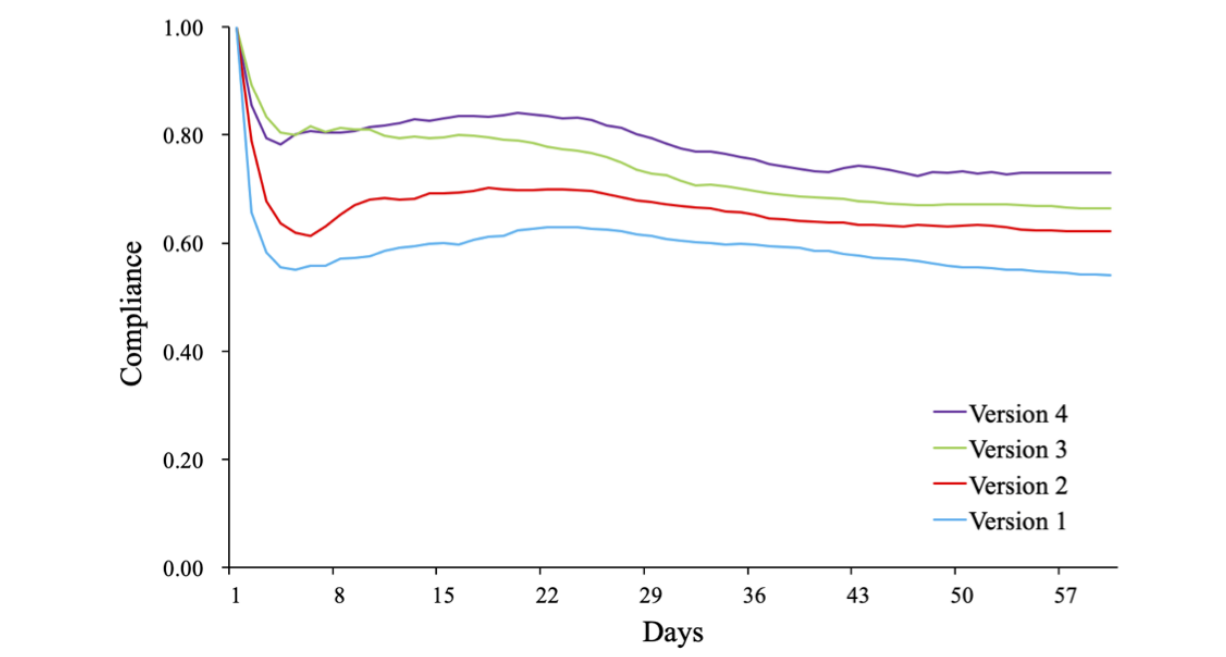
Figure 12. Compliance trends for each app over 2 months.